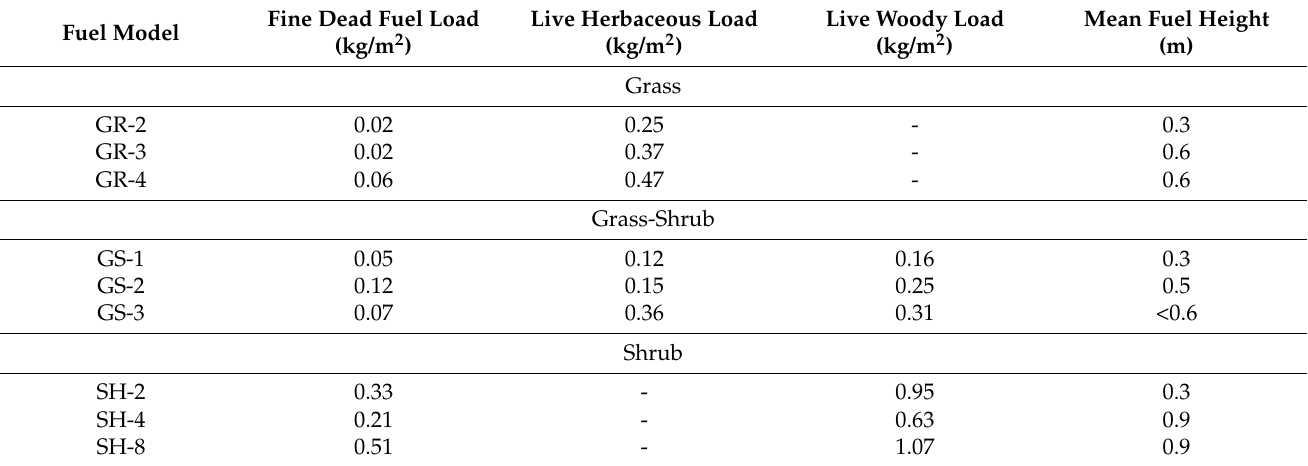
Table 1. Fuel models